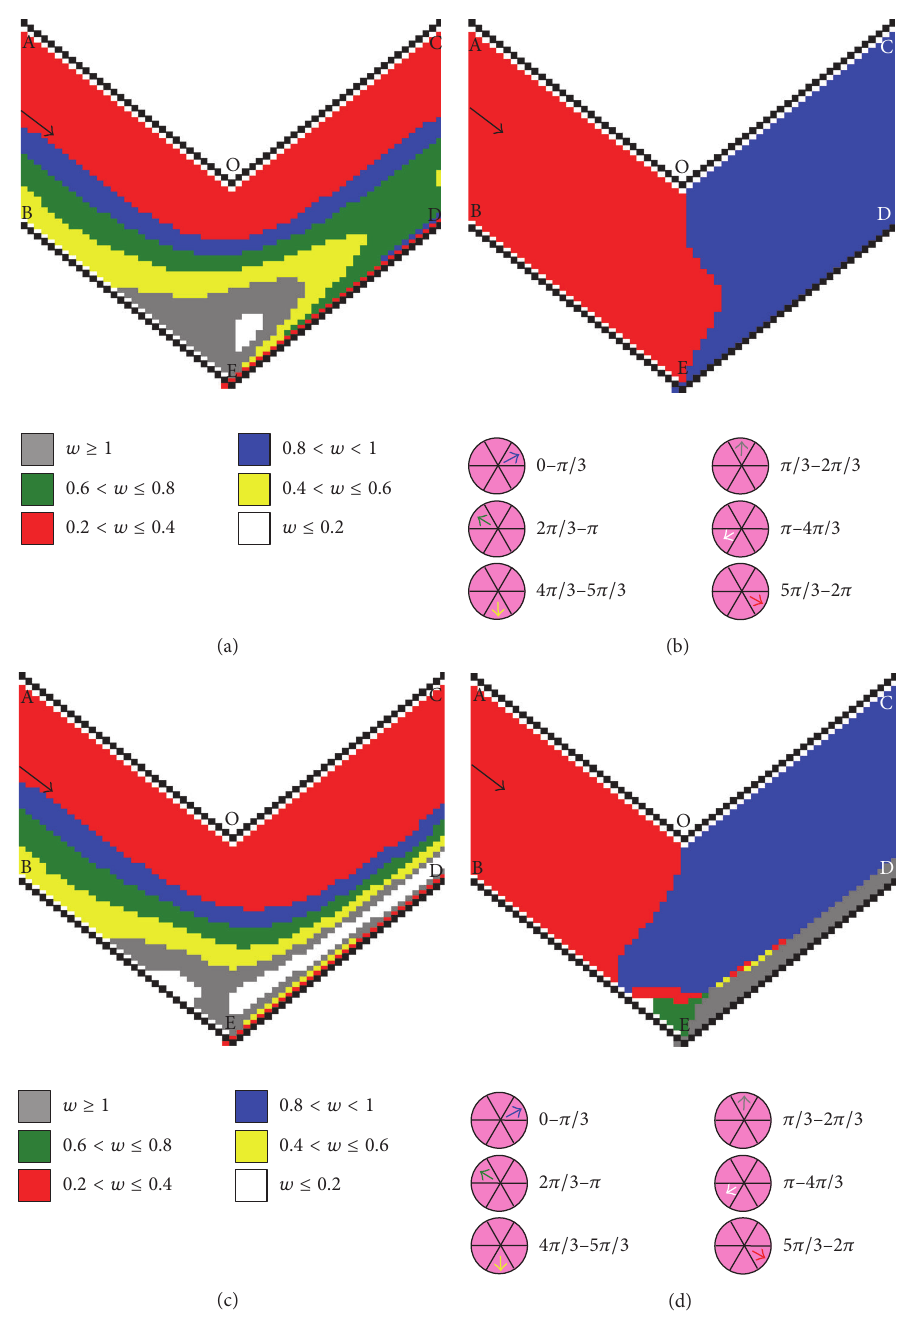
Figure 17: Computational 2D diagrams for the absolute value of dimensionless flow velocity 𝑤 (a, c) and for directions of the vectors of dimensionless flow velocity w (b, d) for the viscous flow of a plasticine workpiece model through obtuse-angled equal channel angular dies AOC–BED of Segal geometry (a, b) with channel intersection angles ∠ (AOC) = 2 𝜃 = 105, where outlet die wall ED moves upstream towards the punching direction with velocity 𝑉 𝑤 = −𝑈 0 (c, d), outlet die wall ED moves downstream stream-wise with velocity 𝑉 𝑤 = +𝑈 0 (a, b), the inlet AB is at the left, and the outlet CD is at the